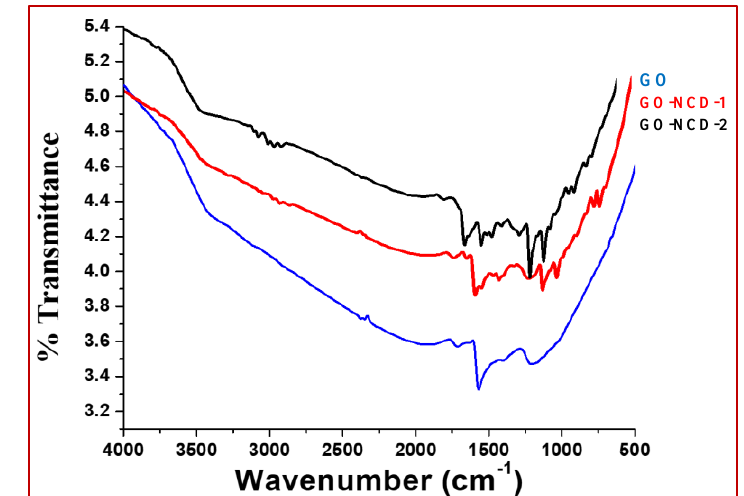
Figure 1. IR spectra of GO, GO-NCD- 1, and GO-NCD- 2.